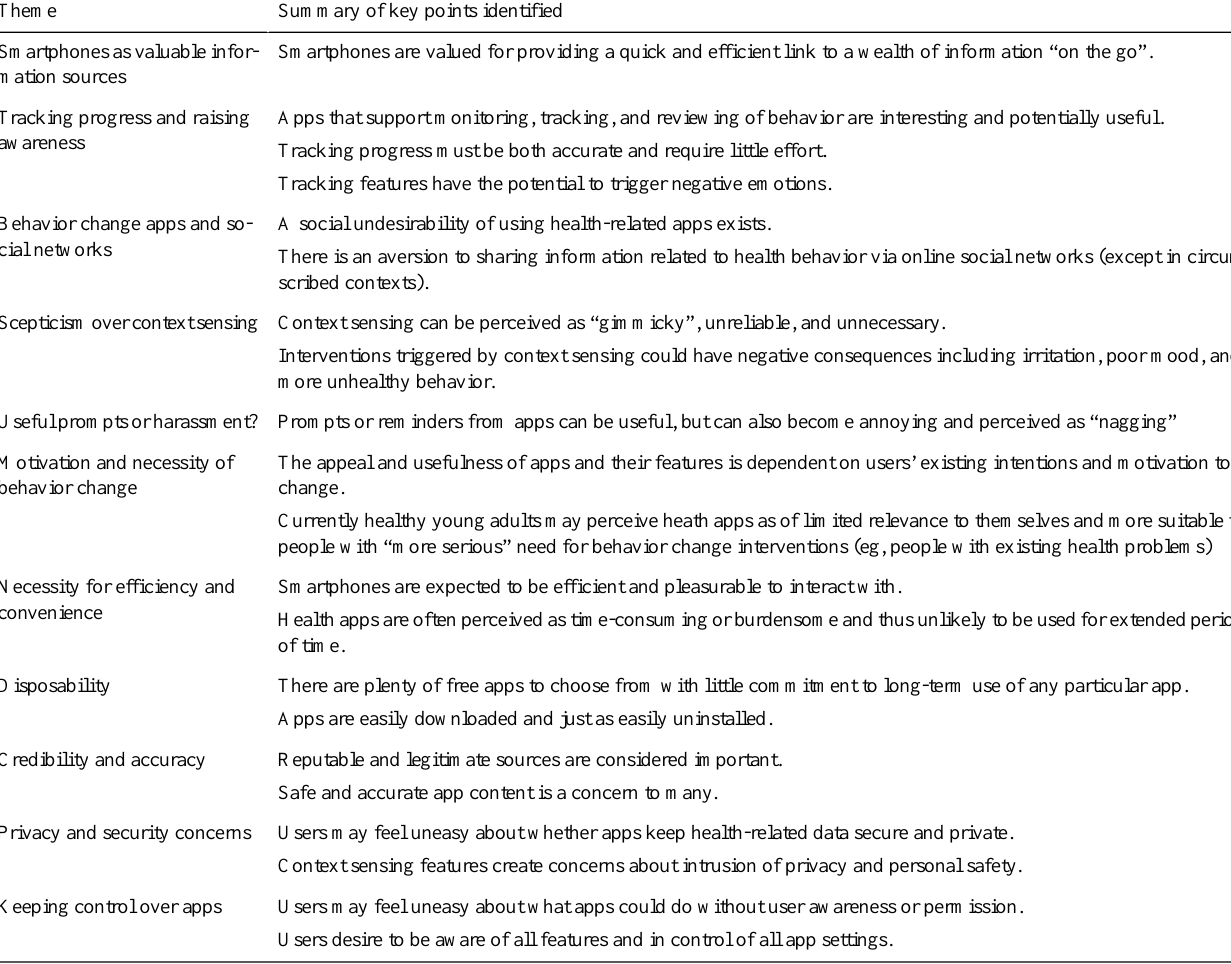
Table 1. Overview of themes.